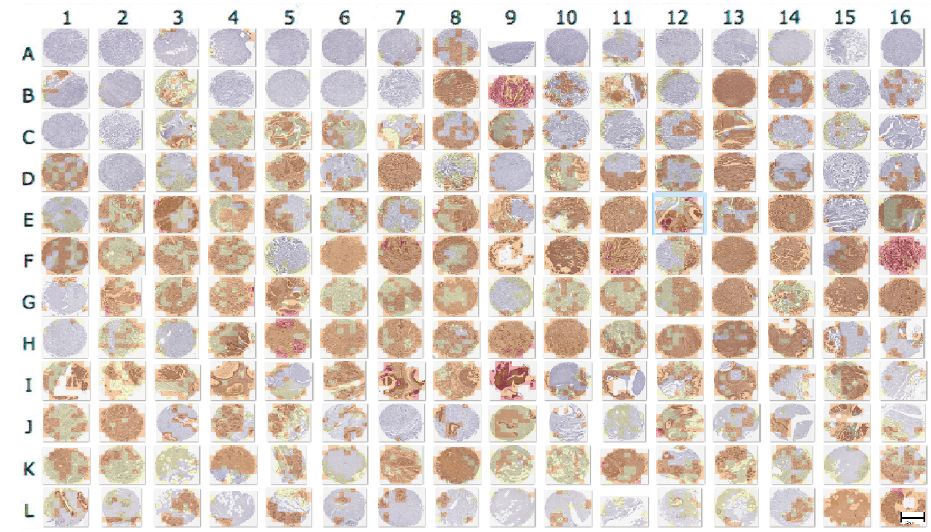
Figure 5. Results obtained for Wnt-1 positive classification in complete TMA tissue core images, scale bar = 20 µ